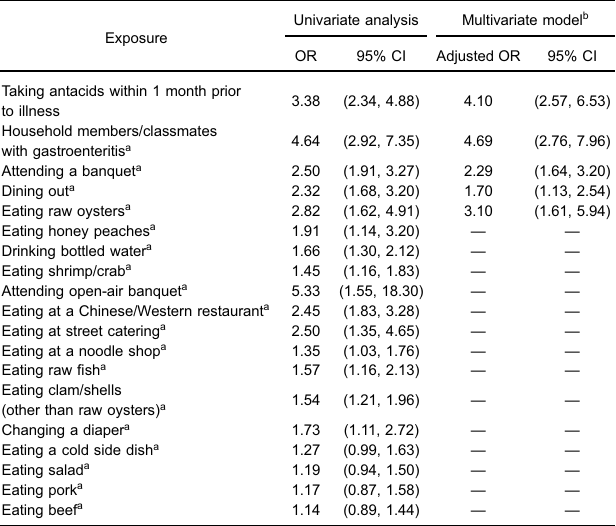
Table 5. Results from accelerated failure time model for illness duration of patients with acute